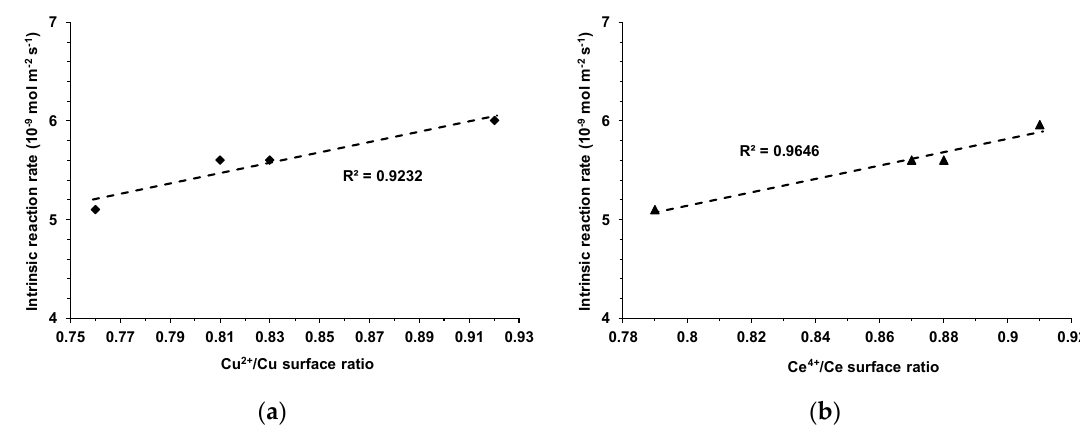
4567 R² = 0.9232 Figure 12. Intrinsic rate of methane conversion measured at 400 °C as a function of ( a ) Cu 2+ /Cu and Figure 12. Intrinsic rate of methane conversion measured at 400 ◦ C as a function of ( a ) Cu 2 + / Cu and ( b ) ( b ) Ce 4+ /Ce surface atomic ratios in the Co(x)CuCeMgAlO catalysts. Ce 4 + / Ce surface atomic ratios in the Co(x)CuCeMgAlO catalysts. Catalysts 2020 , 10 , x FOR PEER REVIEW Figure 13. Intrinsic rate of methane conversion measured at 400 ◦ C vs. hydrogen consumption in the Figure 13. Intrinsic rate of methane conversion measured at 400 °C vs. hydrogen consumption in the H 2 -TPR experiments for the Co(x)CuCeMgAlO H 2 -TPR experiments for the Co(x)CuCeMgAlO catalysts.